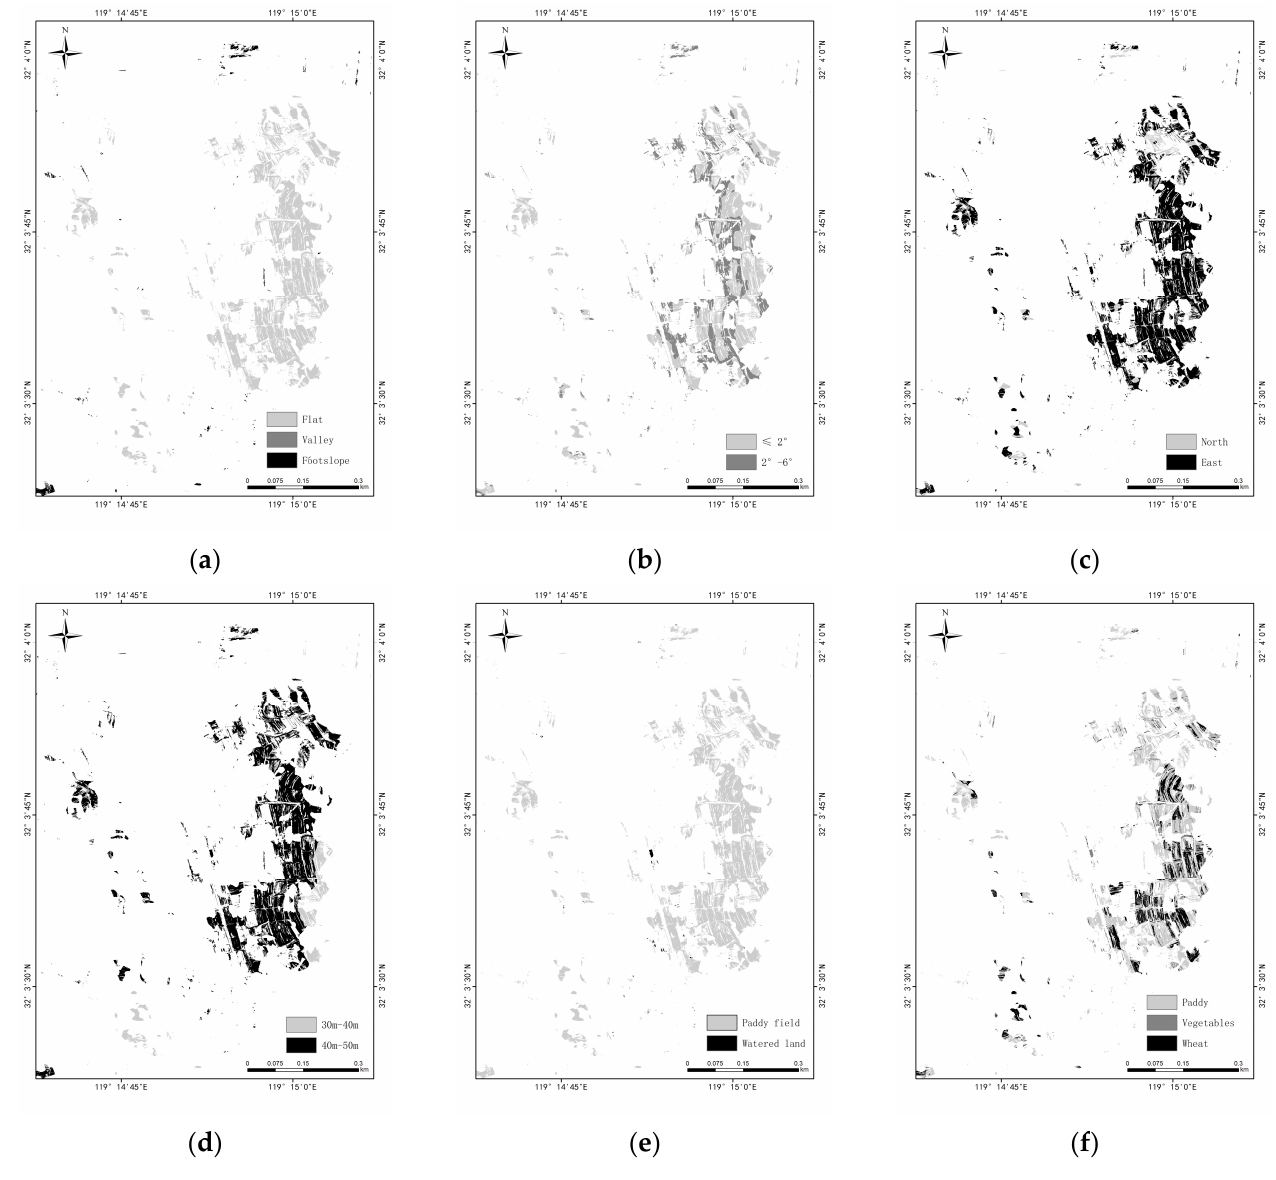
Figure 3. Landscape factor composition of t9-s1-a4-d4-l7-o10 ( a ) topography ( b ) slope ( c ) aspect ( d ) dem ( e ) land use ( f ) object.